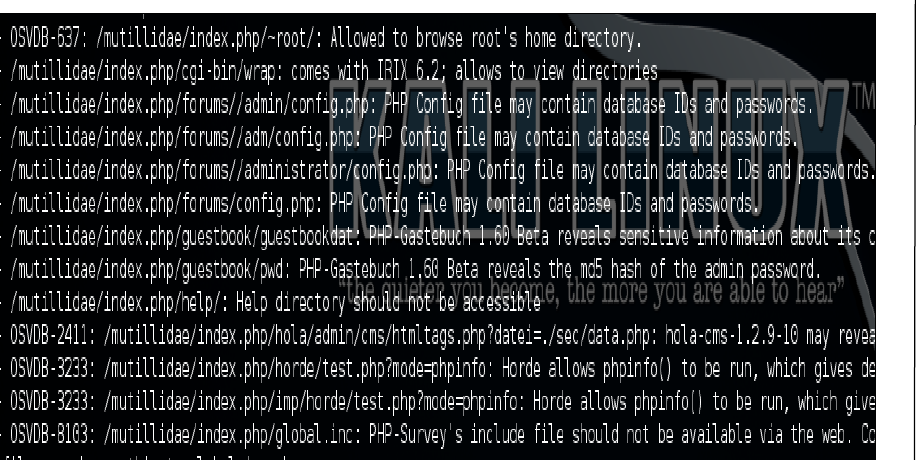
Figure 11 – Nikto - results shown in the terminal Рис . 11 – Nikto – отчет выявленных результатов Slika 11 – Nikto – prikaz rezultata u terminalu